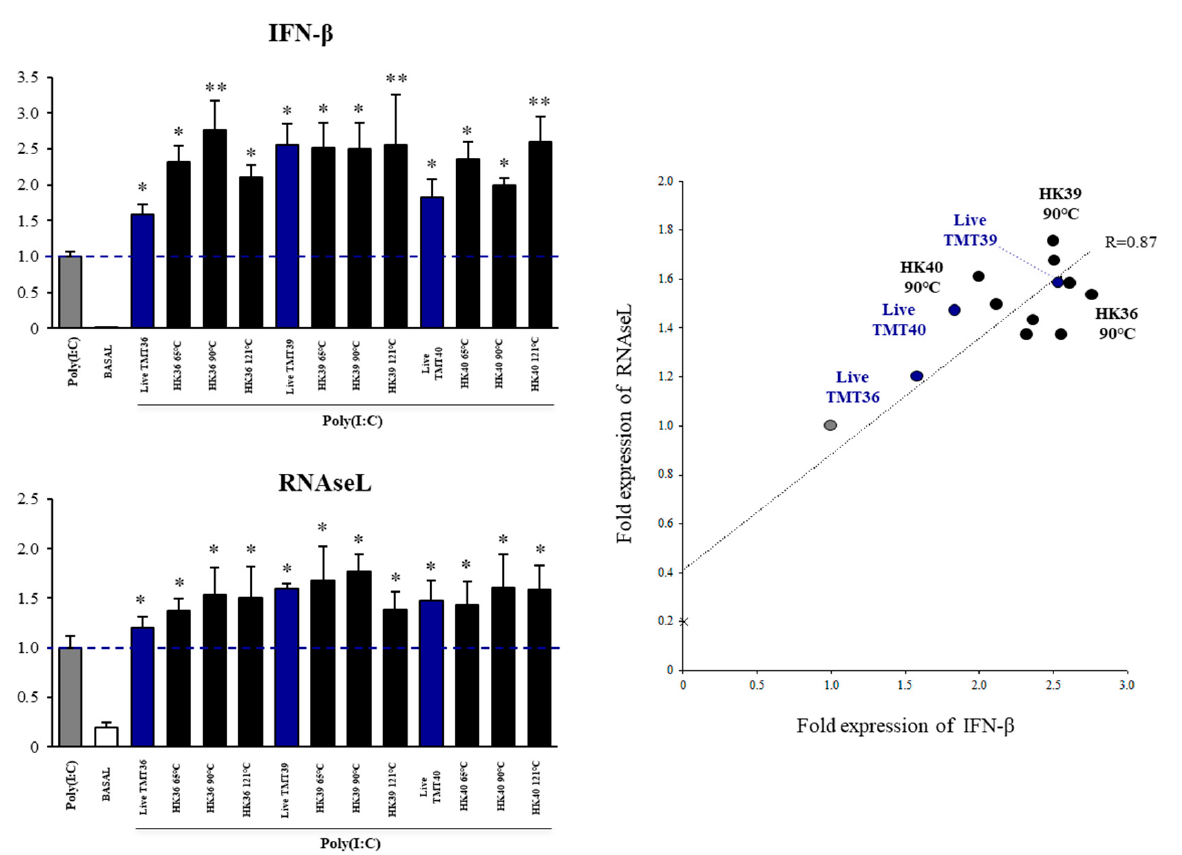
Figure 3. Effect of non-viable lactic acid bacteria strains on the expression of interferon and interferon-induced antiviral genes in porcine alveolar macrophages after the activation of Toll-like receptor 3 (TLR3). Alveolar macrophages were stimulated with viable or non-viable bacteria and then challenged with the TLR3 agonist poly(I:C). The expression of IFN- β and RNAseL were analyzed by qPCR after 12 hours of TLR3 activation. Non-bacteria treated alveolar macrophages challenged with poly(I:C) were used as controls. The results represent data from three independent experiments. Significant differences were observed to poly(I:C)-challenged control porcine alveolar macro- phages. * ( p < 0.05); ** ( p < 0.01). Correlation between the fold expression of IFN- β and RNAseL by a linear regression function was performed.